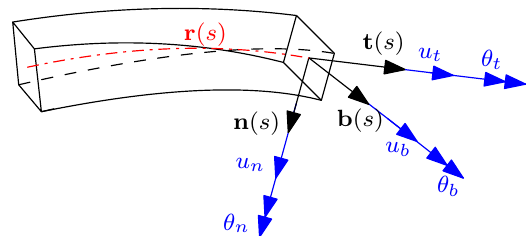
Figure 4. Local coordination system and degrees of freedom of Timoshenko beam